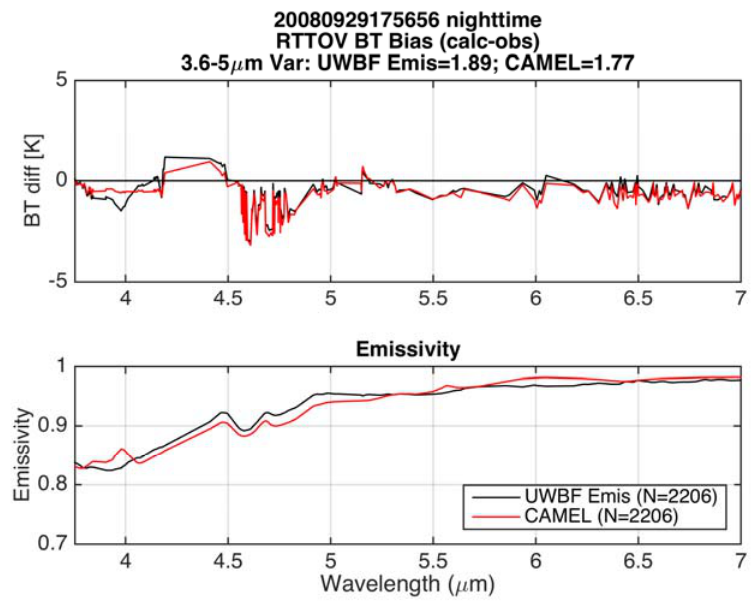
Figure 13. Same as Figure 12 but for the short IR spectral region (between 3.6–7 µm).